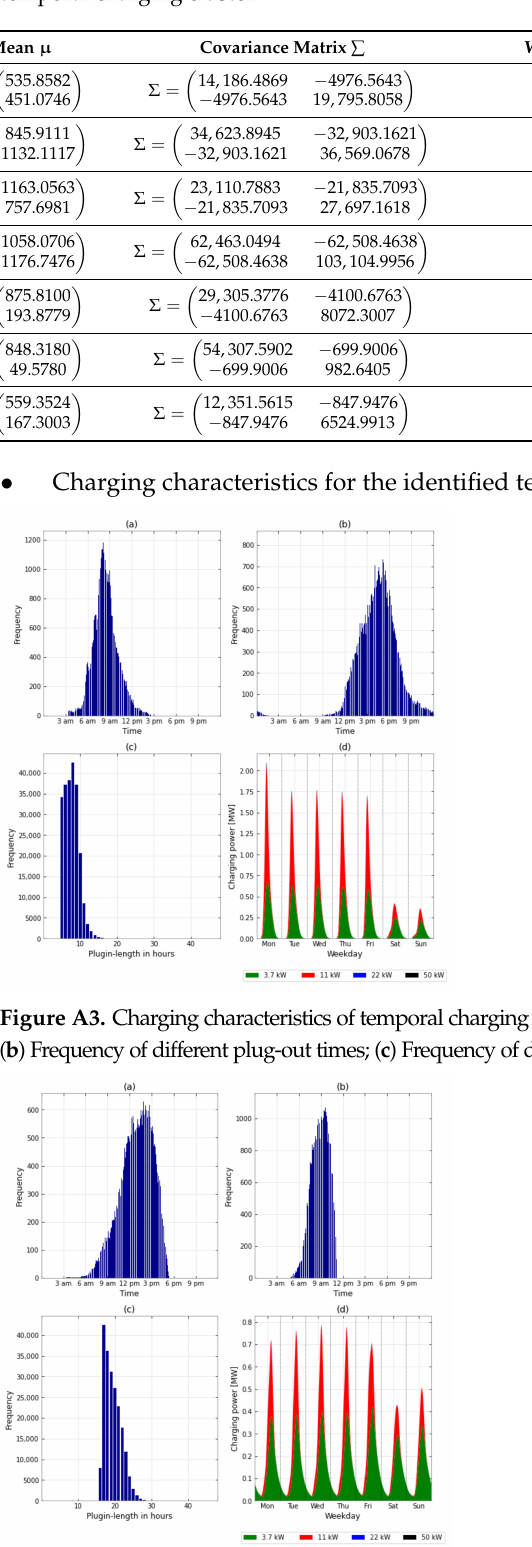
Table A1. The mean, weight and covariance of each cluster and the total number of samples in each temporal charging cluster.